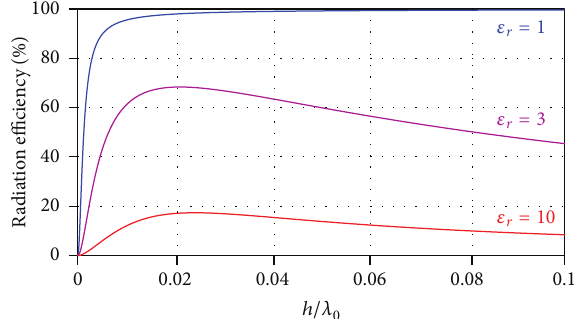
Figure 1: Radiation efficiency of a rectangular patch antenna as a function of the relative substrate height; see